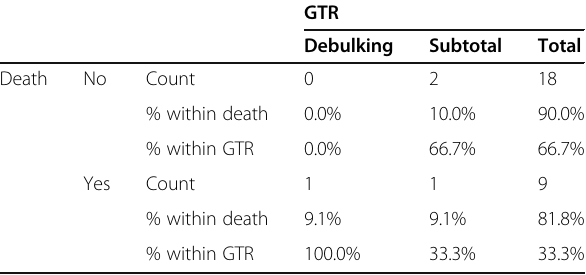
Table 5 The relationship between mortality and